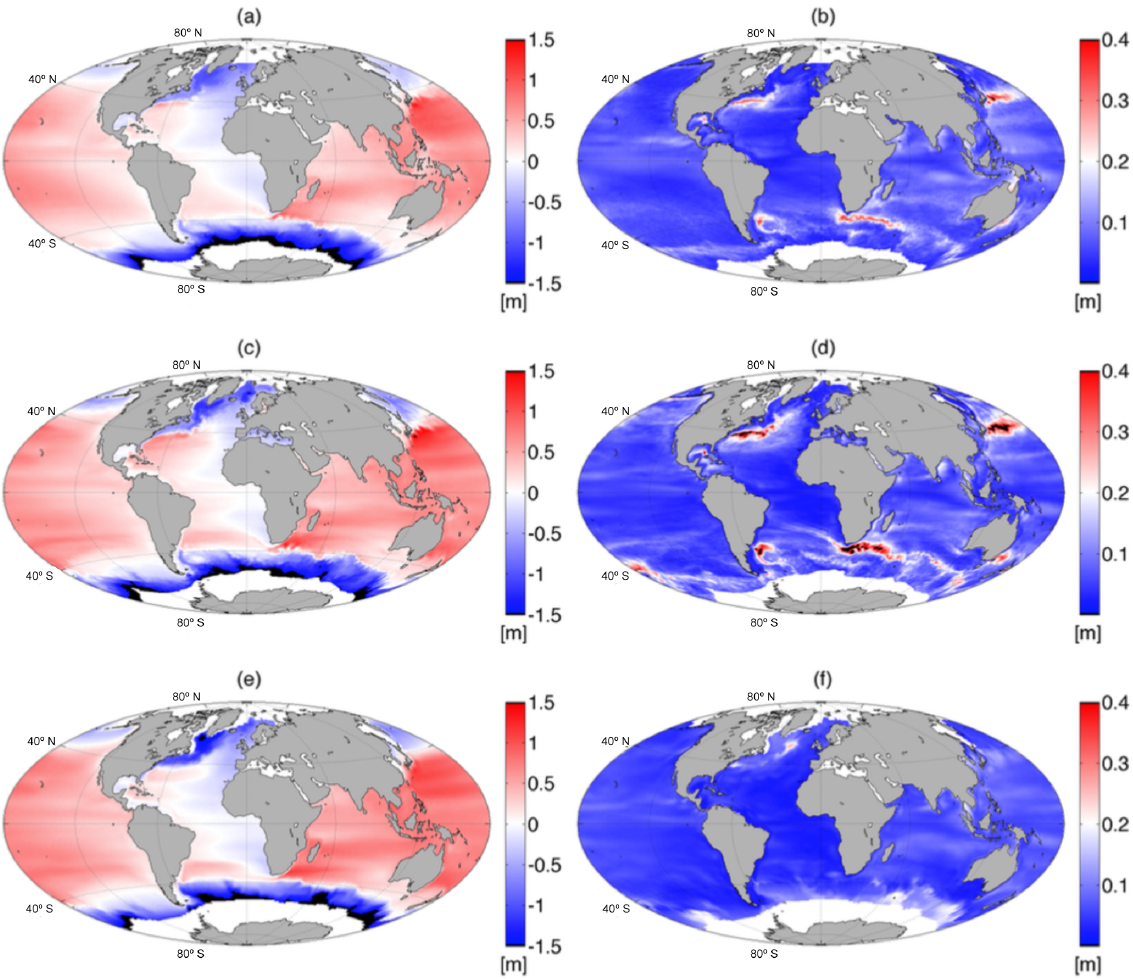
Figure 1. Mean sea surface height (SSH in meters) (a–c) and its standard deviation (b–d) over the years 1993–2012. (a) and (b) are derived from altimetry and (c) and (d) of the high-resolution simulation R 021 . Panels (e) and (f) show the mean SSH and the standard deviation for the low-resolution simulation R low , 021